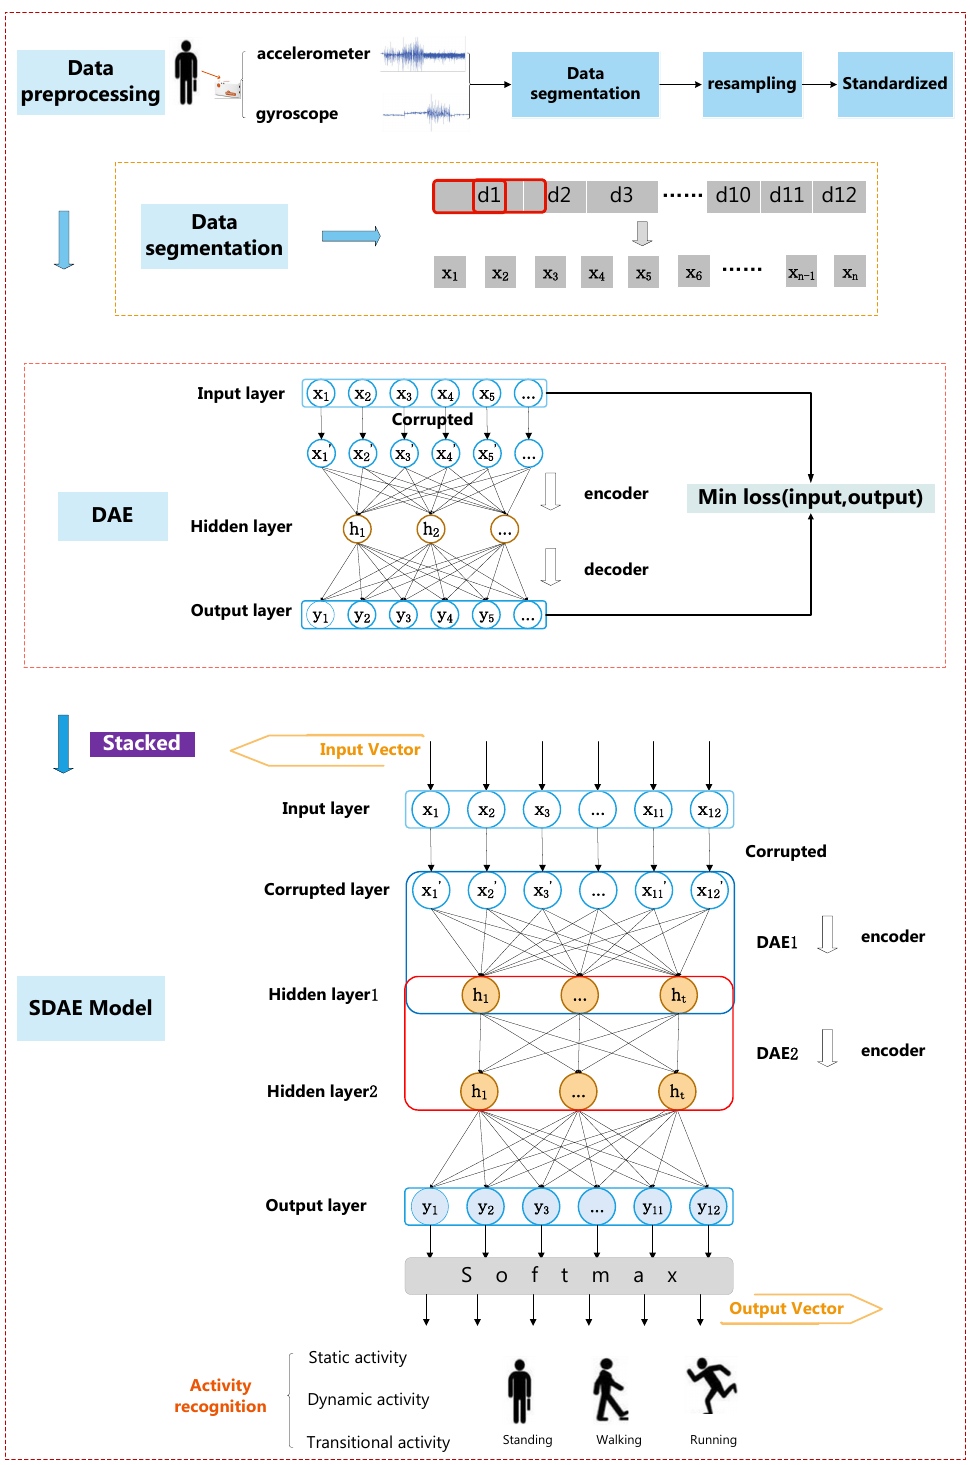
Figure 1. The overall framework of stacked denoising autoencoder (SDAE)-based activity